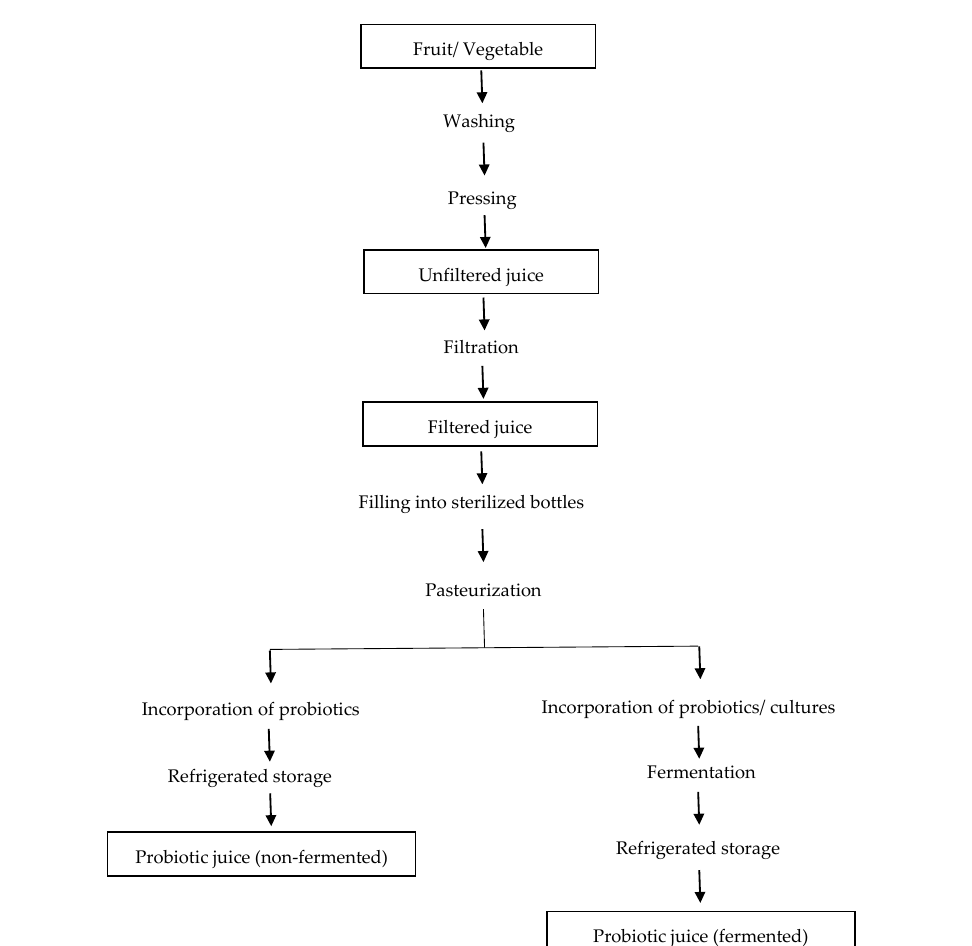
Figure 2. Flow chart for the production of fermented and non-fermented fruit/vegetable juices enriched with probiotics.